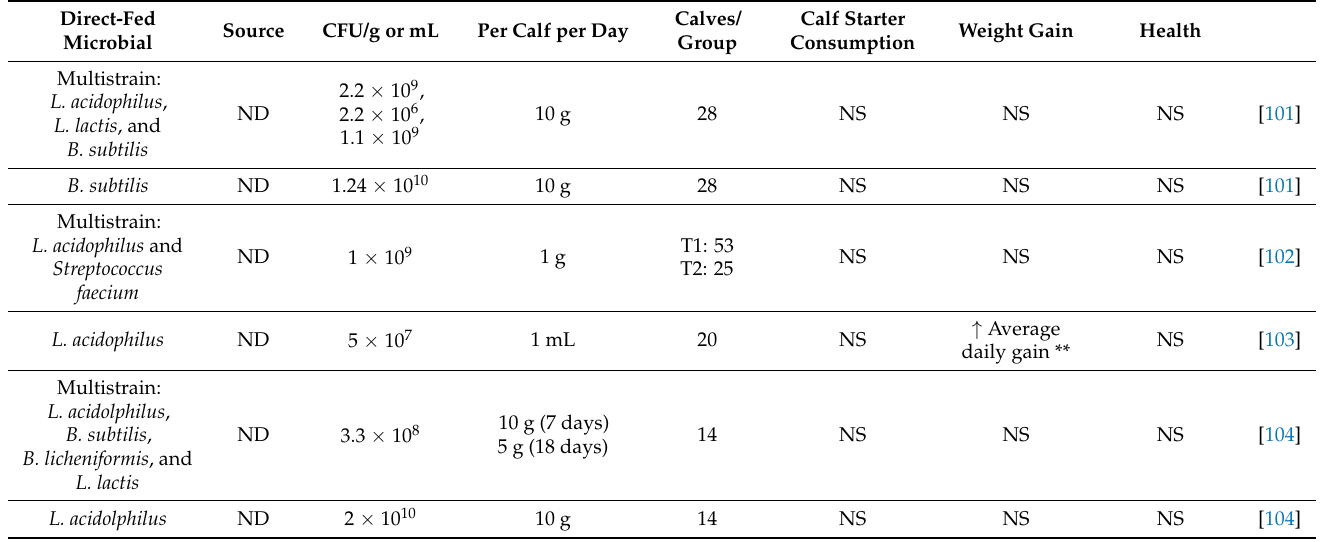
Table 1. DFMs that have been investigated for effects on calf performance, listed in chronological